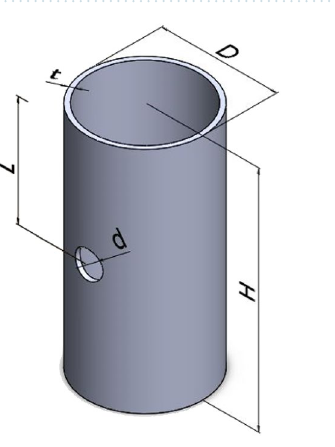
Figure 3. A schematic view of test